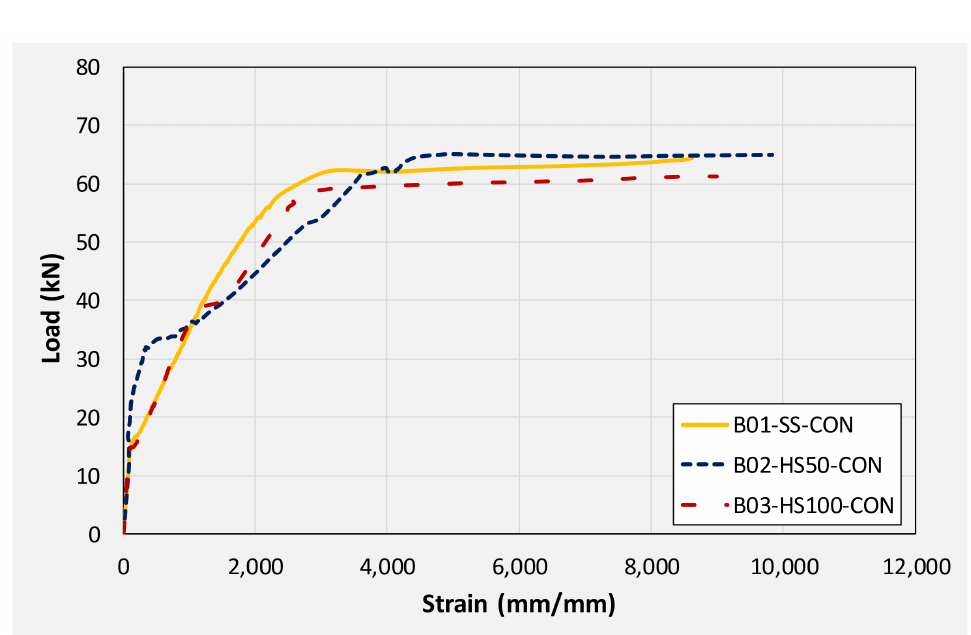
Figure 21. Monitored positive steel strain in beams B01, B02, and